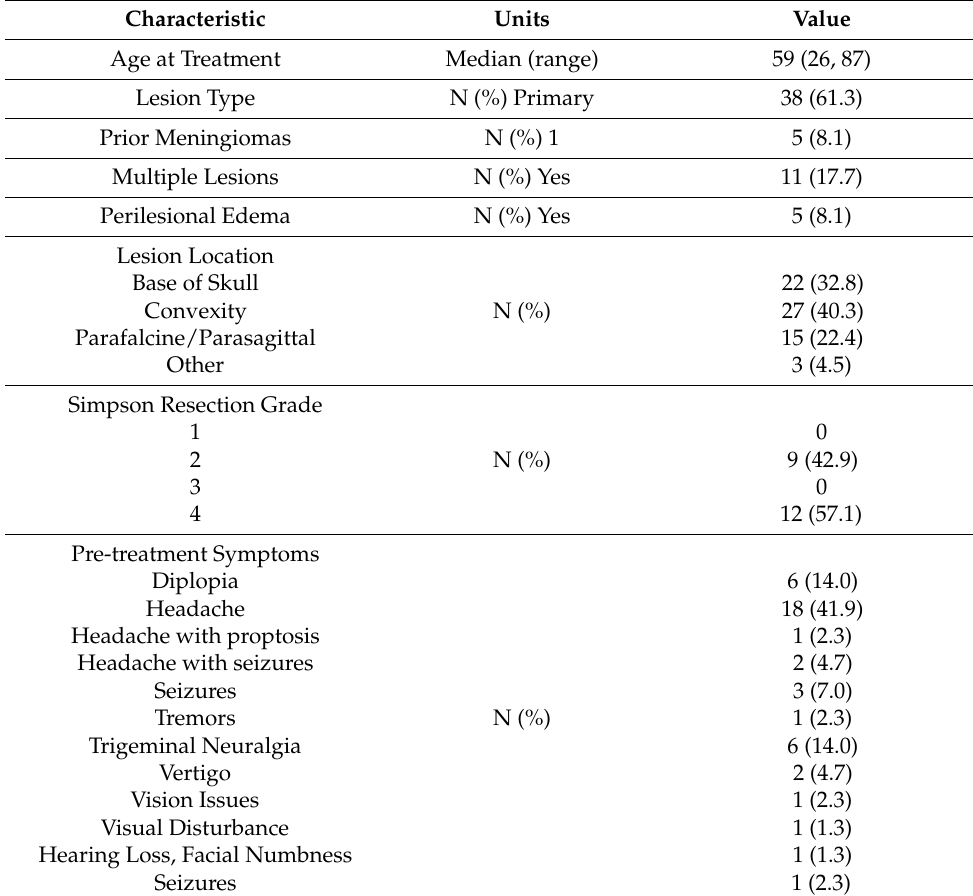
Table 1. Descriptive